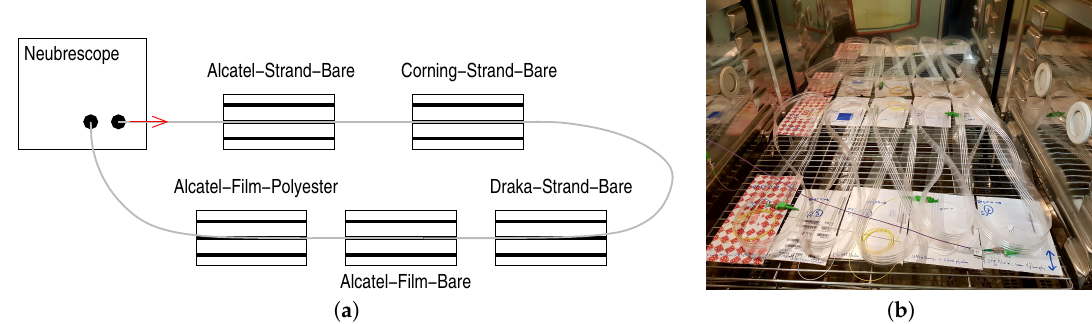
Figure 7. ( a ) Assembly diagram of straps. ( b ) Arrangement of the straps assembly in the thermal